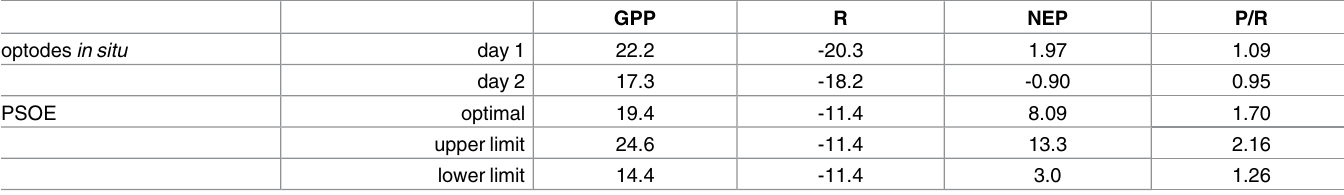
Staehr et al. [23] method was used to fit optode in situ measurements, whereas Bright and Walsby [49] method was used to model production integral according to laboratory photosynthetic oxygen evolution (PSOE)